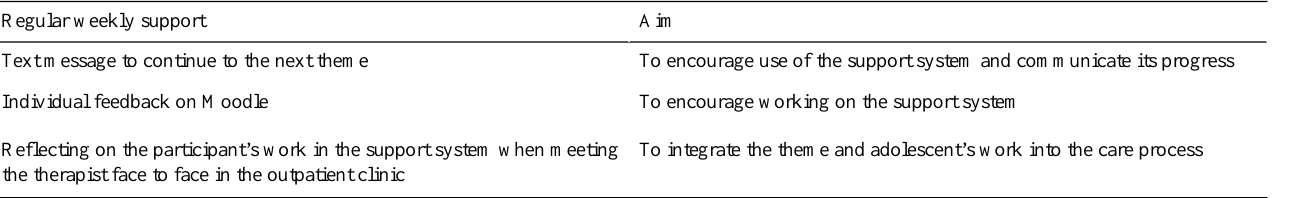
Table 3. Regular support provided in the Internet-based support system.